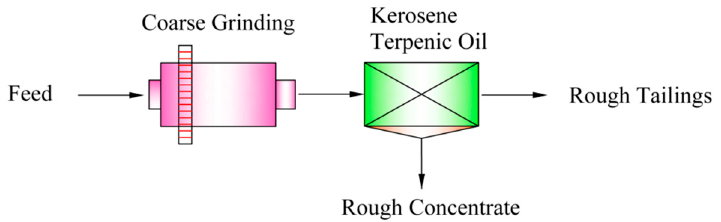
Figure 3. Flowchart of coarse grinding and rough flotation for experimental parameters.